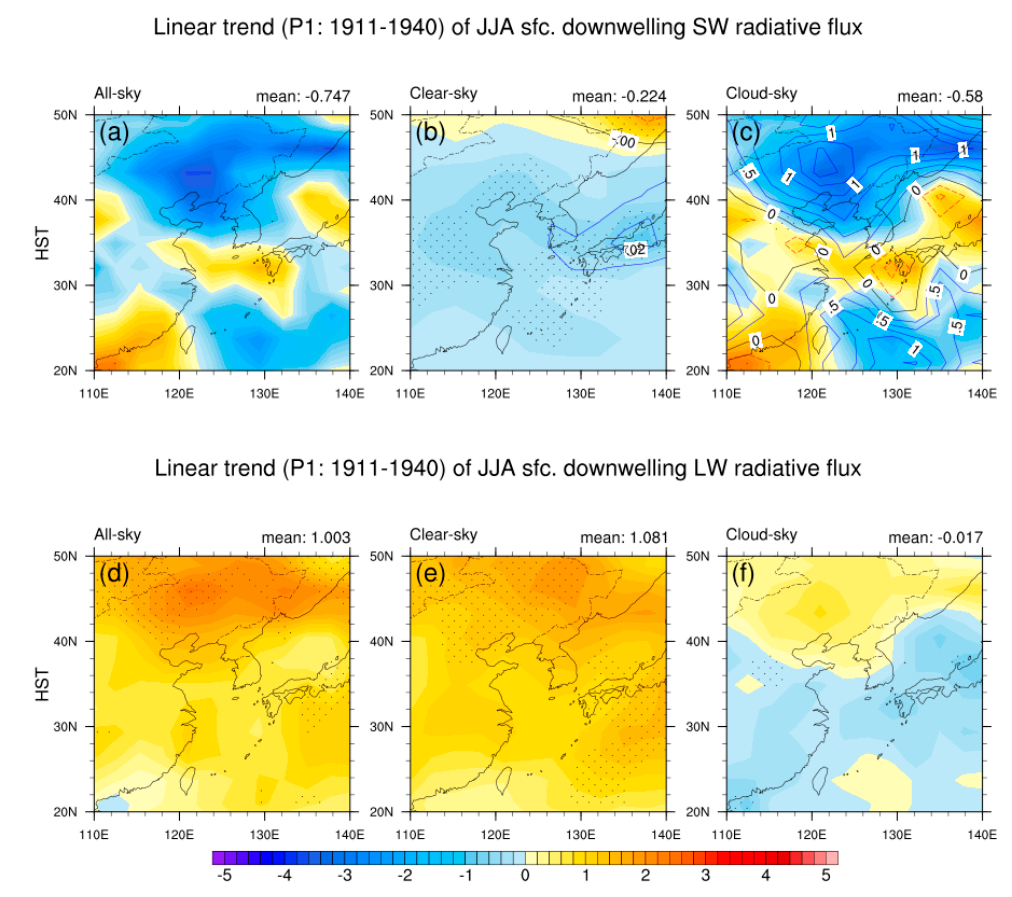
Figure 5. The linear trends of the JJA mean downwelling SW (upper panel, shading) and LW (bottom panel, shading) radiative flux at the surface (Wm − 2 decade − 1 , positive downward) according to cloud condition in the early 20th century (1911–1940); ( a , d ) all-sky; ( b , e ) clear-sky with total aerosol optical depth trend (contour in upper panel, positive solid line); ( c , f ) cloudy-sky with total cloud fraction trend (contour in upper panel) in HST. The dotted areas indicate that the trends are statistically significant at 10% level. The domain average has been shown in the right corner.